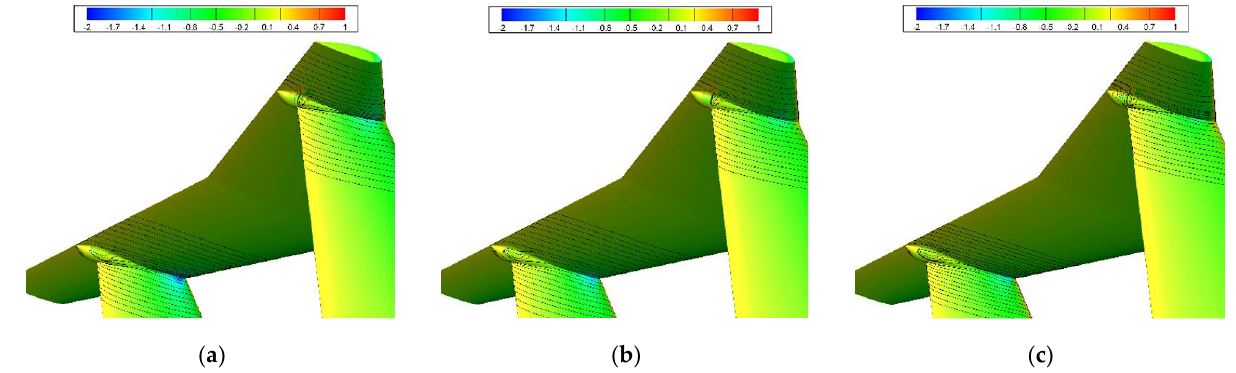
Figure 17. Streamlines and C p distribution on pressure side for modified model: β = ( a ) 0°, ( b ) 2°, and ( c ) 4°.